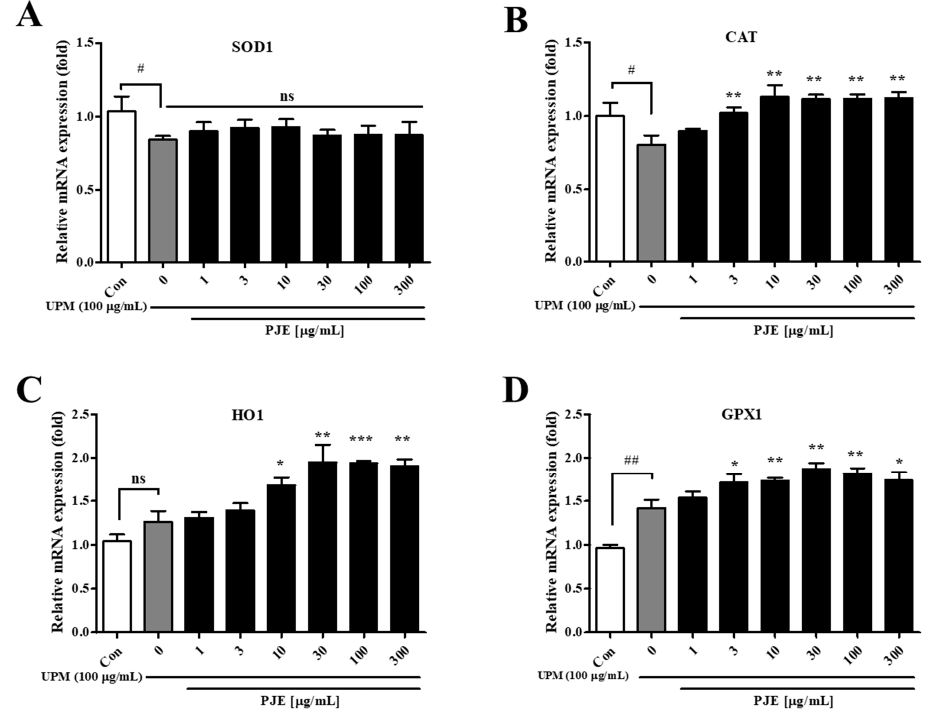
Figure 4. Effects of PJE on the mRNA expression of antioxidative genes in HCECs. After the scratch assay, the relative mRNA expression levels of ( A ) SOD1, ( B ) CAT, ( C ) HO1 and ( D ) GPX1 were analyzed, and the fold changes are presented compared with the Con as the means ± SD. # p < 0.05, ## p < 0.01 compared to Con; * p < 0.05, ** p < 0.01, *** p < 0.001 compared to 0 μ g/mL PJE; ns, not significant.